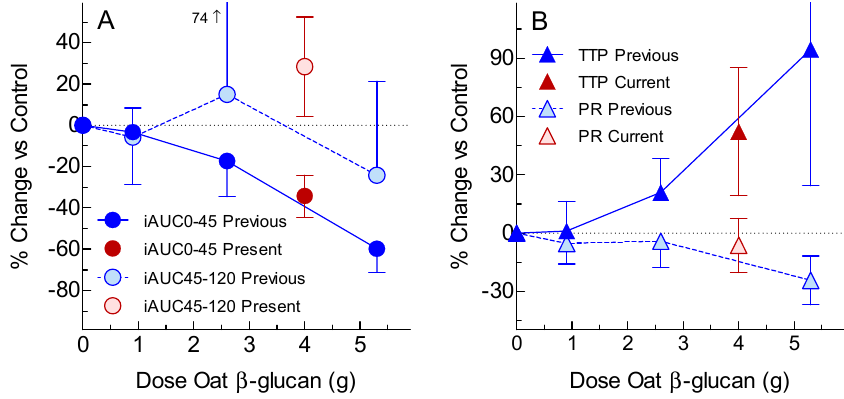
Figure 3. Current results compared to previous results for the same oat-bran treatment. Values are means ± 95% confidence intervals of the percentage change from control (0 g oat β -glucan). The previous study [13] tested the e ff ects of a commercially available oat bran containing 0.9, 2.6 and 5.3 g of oat- β -glucan given as a preload on the glycemic response elicited by white bread in n = 10 subjects (blue symbols) using the same protocol as the present study. The present results for the same source of oat β -glucan used in the previous study (i.e., OP1) are shown with red symbols. Panel A shows the incremental area under the glucose curve (iAUC) from 0–45 min (dark circles) and from 45–120 min (light circles). Panel B shows the time to reach the peak (TTP; dark triangles) and peak rise (PR; light triangles).